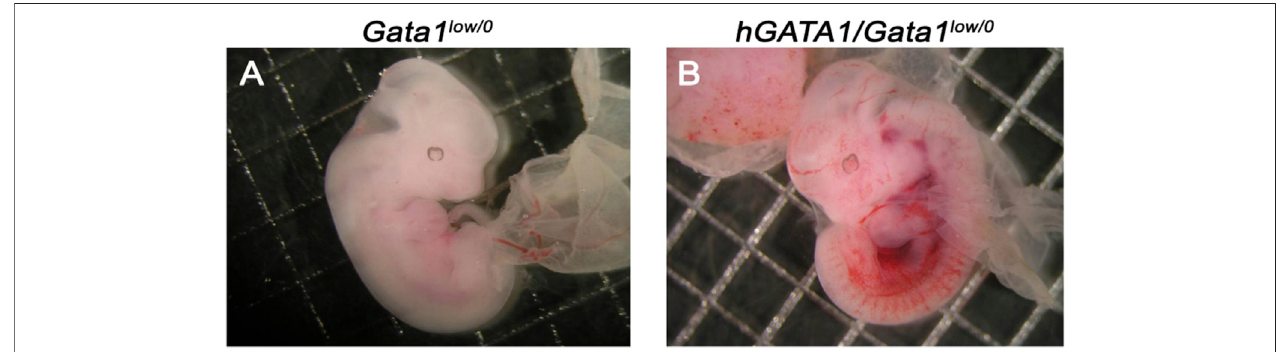
FIGURE 1 | Fetuses from GATA1 low/0 mice carrying the hGATA1 transgene are not anemic. Representative photograph of 11.5 days fetuses from the same litter. The genotype of the fetuses is indicated on the top. Compared to age-matched Gata1 low/0 mice (A) , the double mutant hGATA1/Gata1 low/0 mice (B) are not anemic. Results are representative of those observed with 5 fetuses per